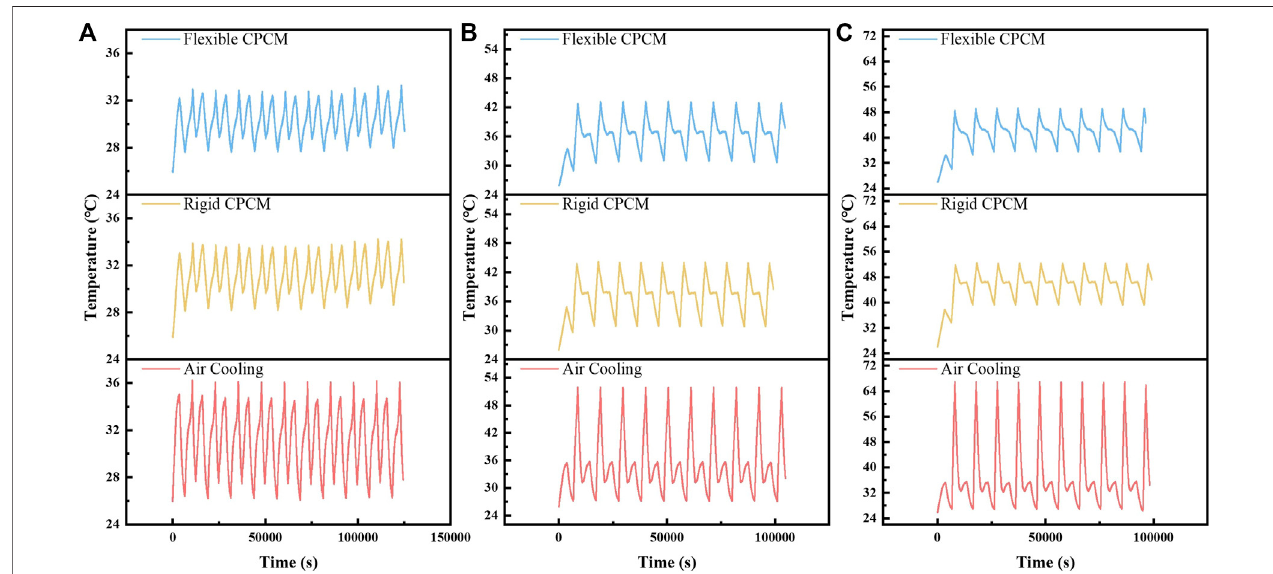
FIGURE 9 | Temperature curves of the three battery modules in 10 cycles of charge/discharge tests at different discharge rates: (A) 1C, (B) 2C, and (C) 3 C.